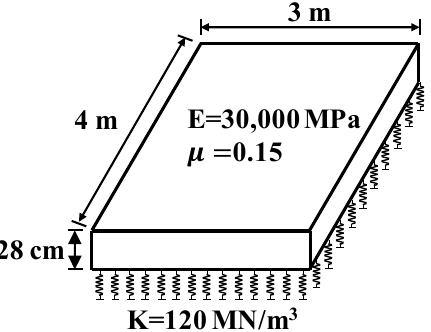
Figure 4. FEA model for convergence analysis.